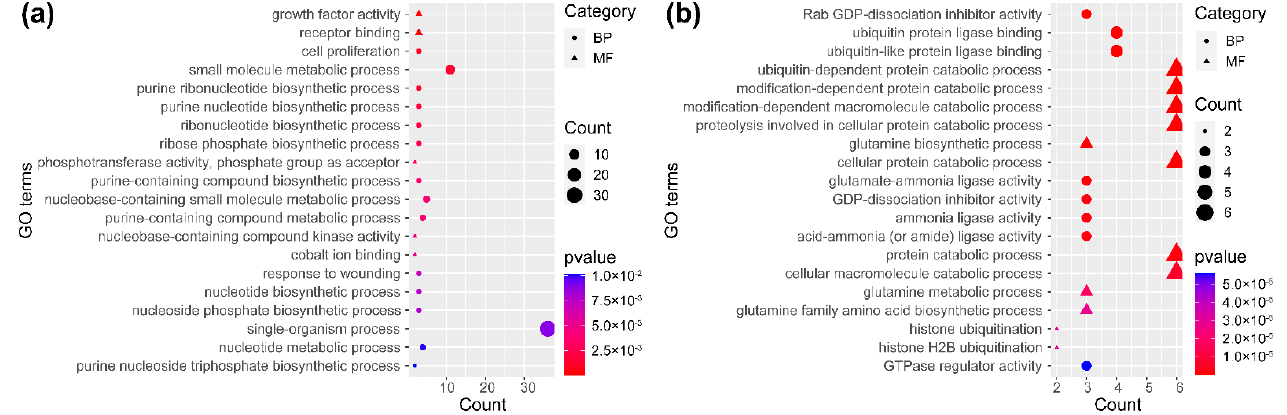
Figure 4. Top 20 terms of GO enrichment of key DEGs ( a ) and DSGs ( b ). BP and MF represent biological processes and molecular functions, respectively.